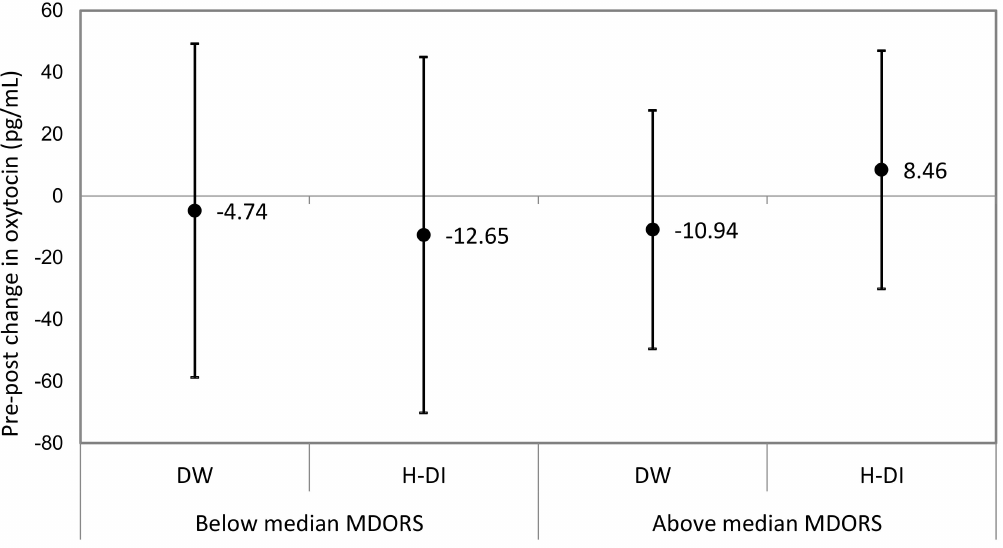
Figure 2. Sub-group analyses of estimated mean pre–post change of urinary oxytocin concentration by the strength of the human–dog bond. DW: dog-walking; H-DI: human–dog